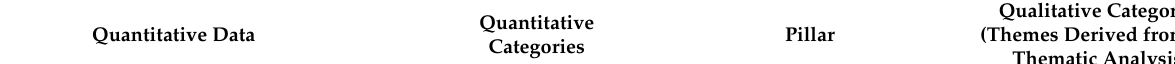
Table 4. A joint display of the connections between the quantitative and qualitative data arising from the study—Pillars 3, 4, 5 and